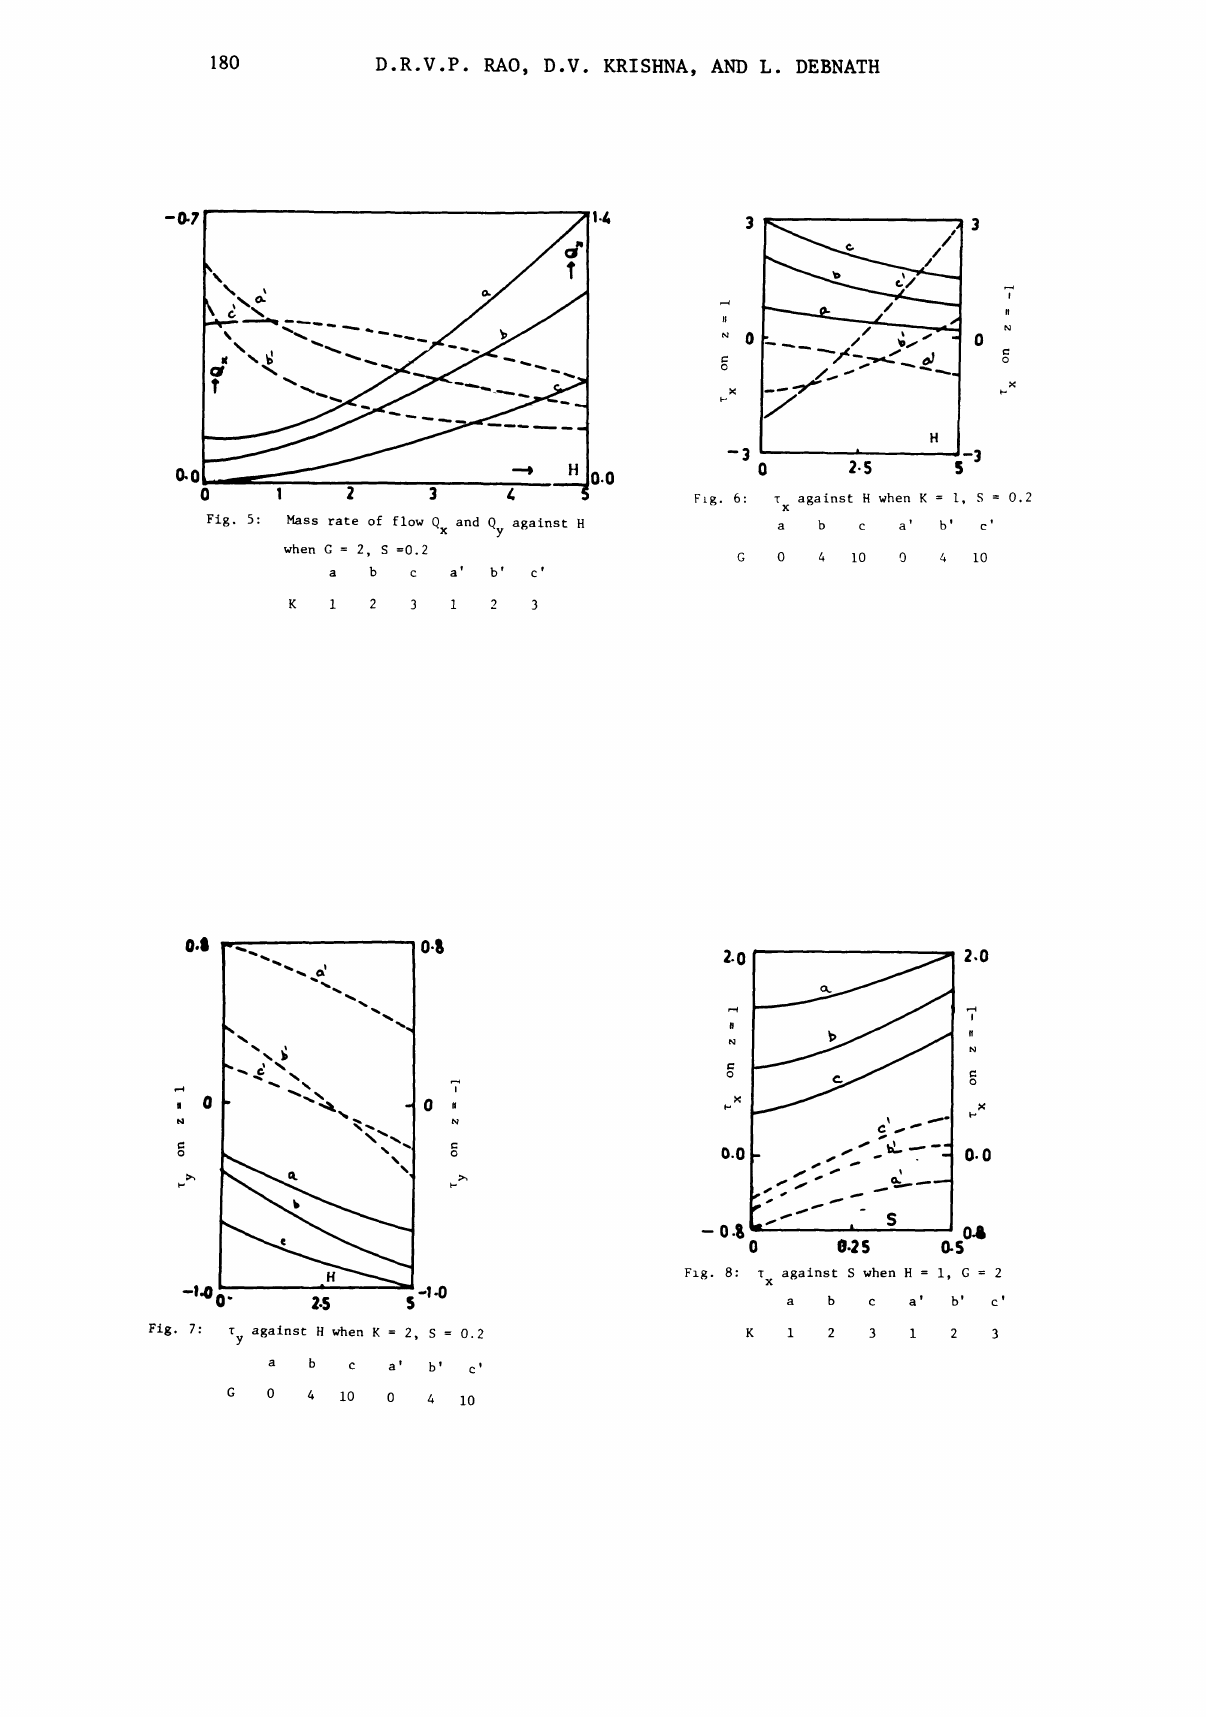
Fig. 5: Mass rate of flow Qx